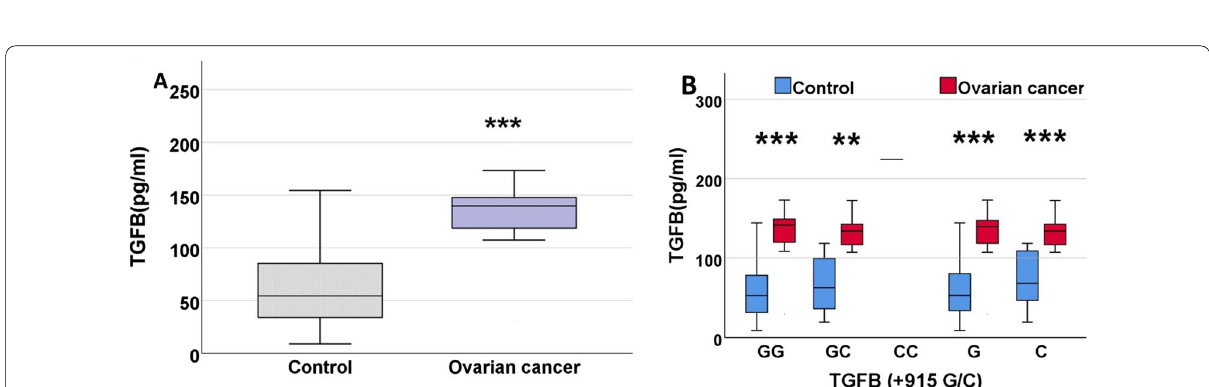
Fig. 4 TGF‑β1 concentration (pg/ml) in relation to A control and ovarian cancer groups, B genotypes and alleles of TGF‑β ( polymorphism in control and ovarian cancer groups. Results are expressed as